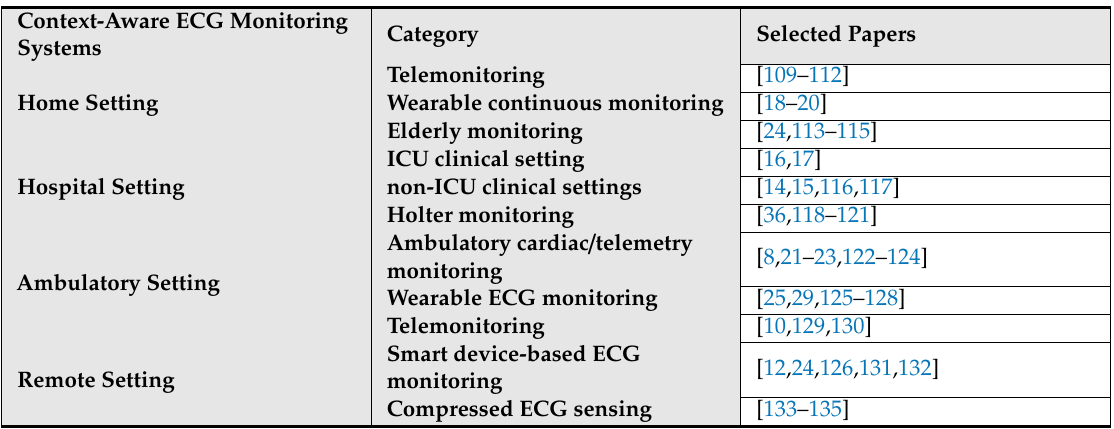
Table 2. Classification of selected context-aware ECG monitoring